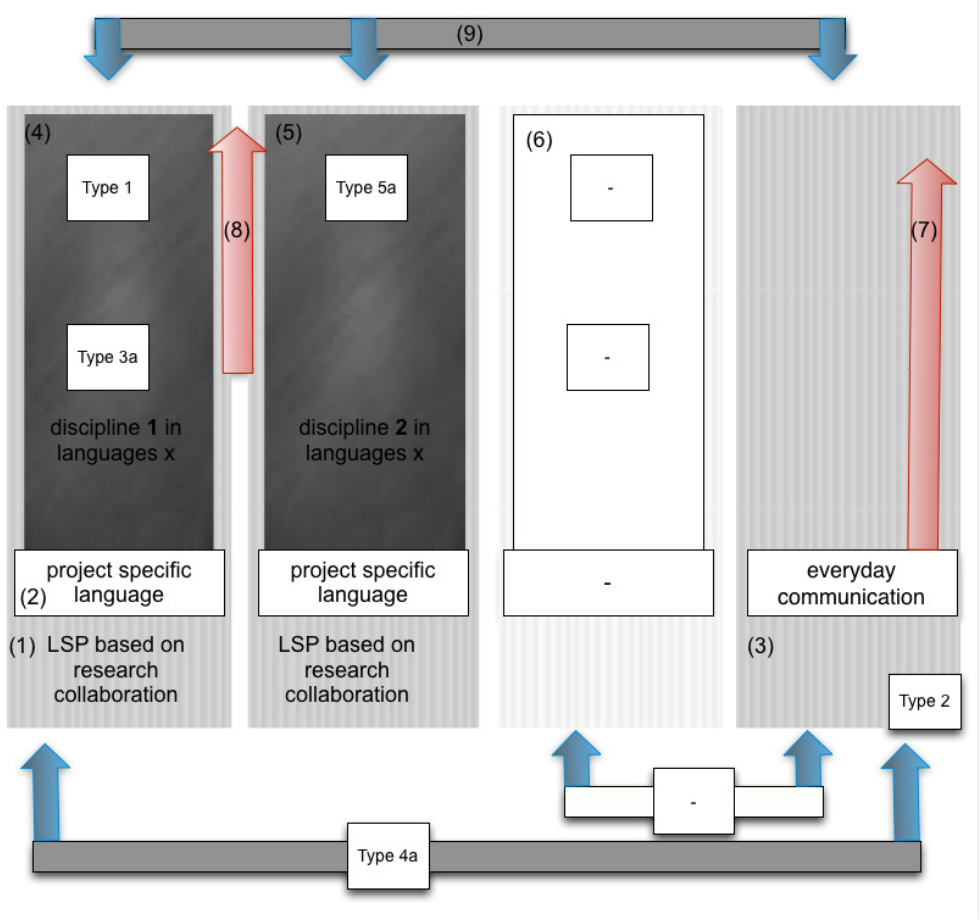
Fig. 10: multidisciplinary research project in the data collection phase As figure 10 shows, there are no type 5 communication situations in these contexts. The different disciplines work on their own and not collaboratively with each other. This also influences the project- specific terminology and the LSP based on the research collaboration. There could still be a project-specific terminology unconsciously developed, but including for instance terms based on administrative topics and not on topics related to research (as described in Pelikan & Roelcke